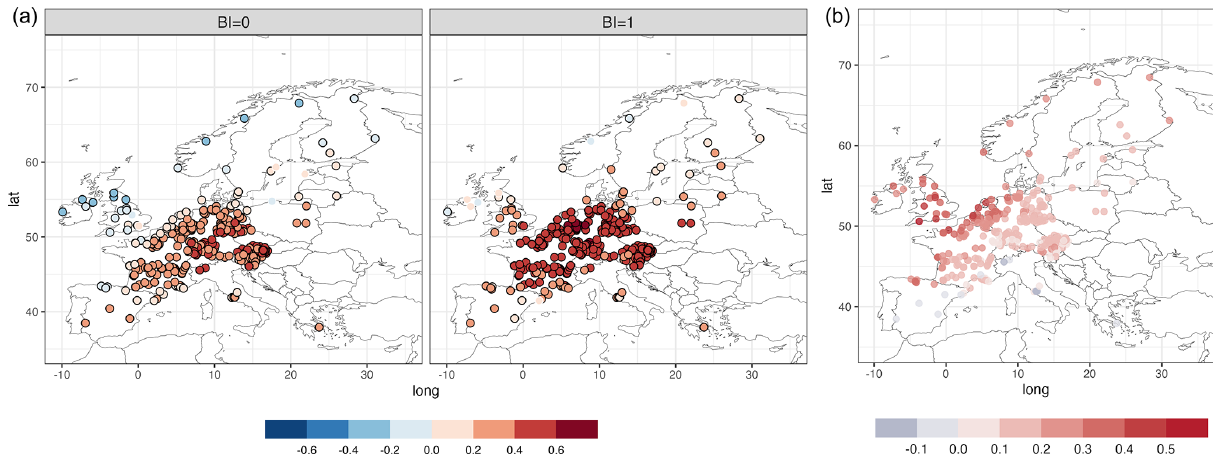
Figure 3. (a) Spatial distribution of Kendall’s correlation coefficient between MDA8O3 and T max under non-blocking conditions (i.e. BI = 0) and blocking conditions (i.e. BI = 1). Black contour indicates statistically significant anomalies at the 95% confidence level of a two-sided t test. (b) Differences between the correlation values obtained when BI = 1 minus the correlations when BI =